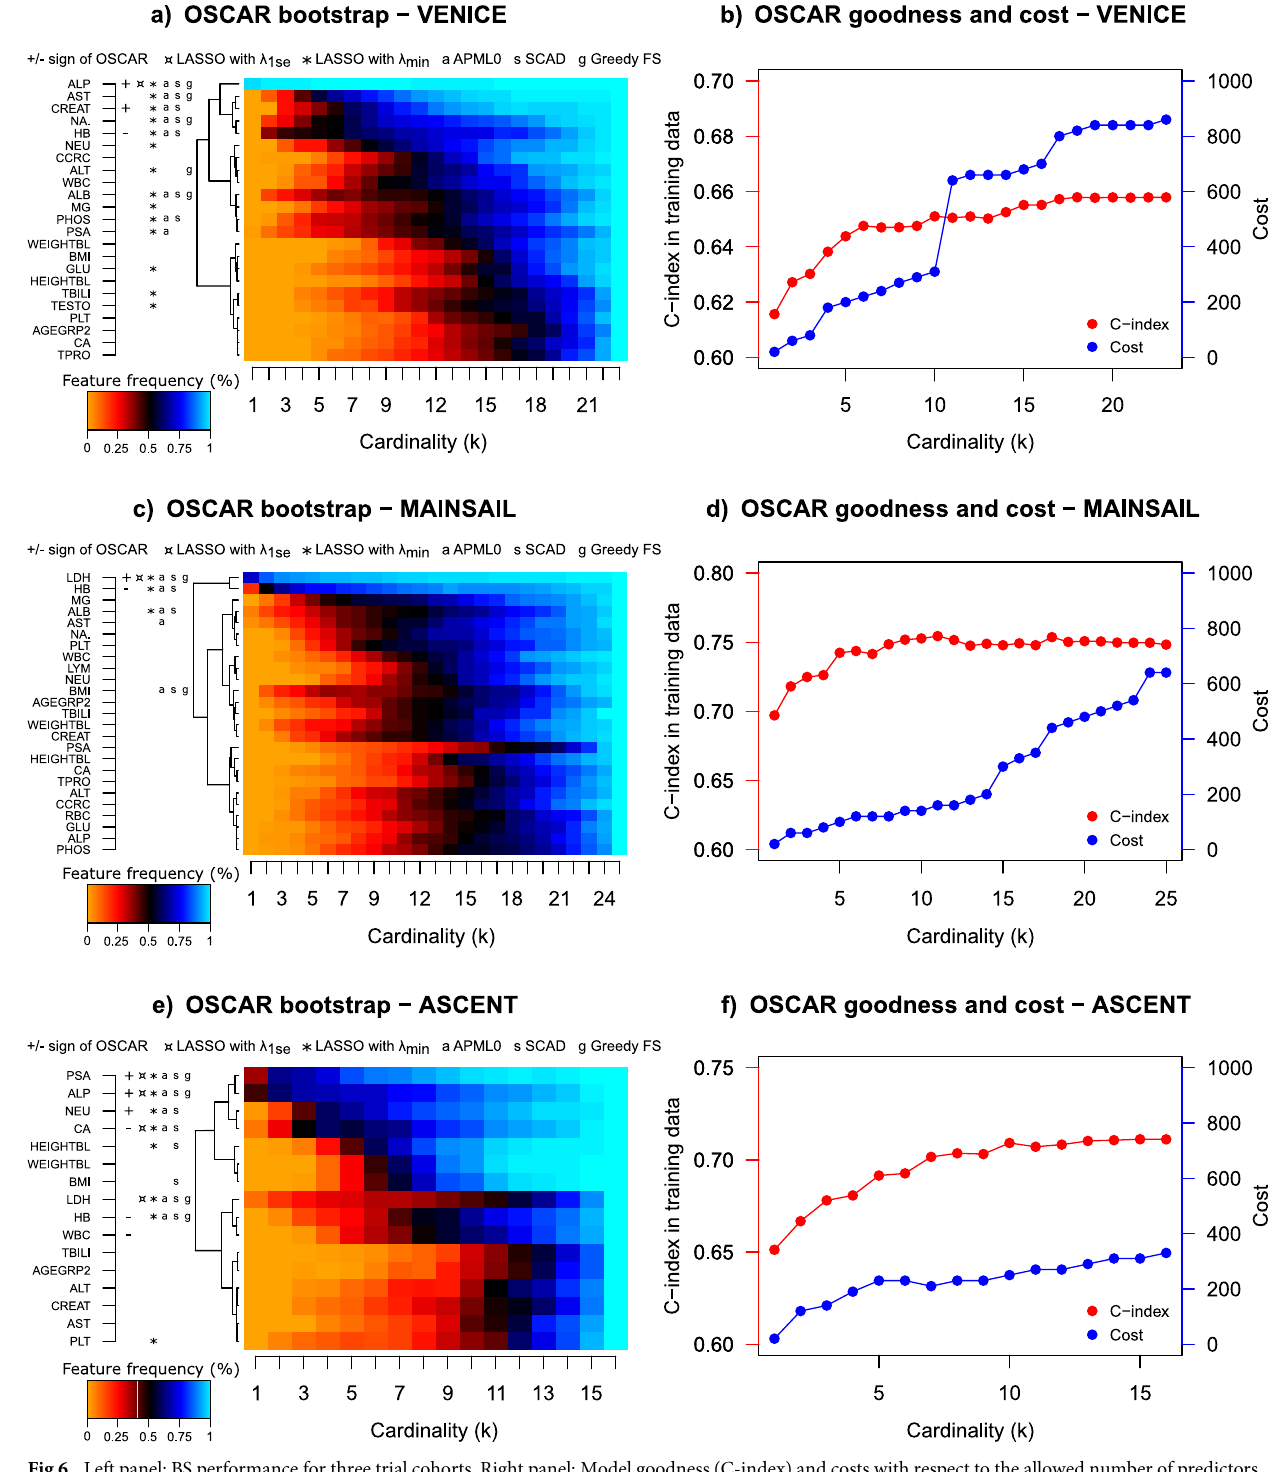
Fig 6. Left panel: BS performance for three trial cohorts. Right panel: Model goodness (C-index) and costs with respect to the allowed number of predictors. Cost is calculated by kits and a kit price is added if any feature from a kit is used.